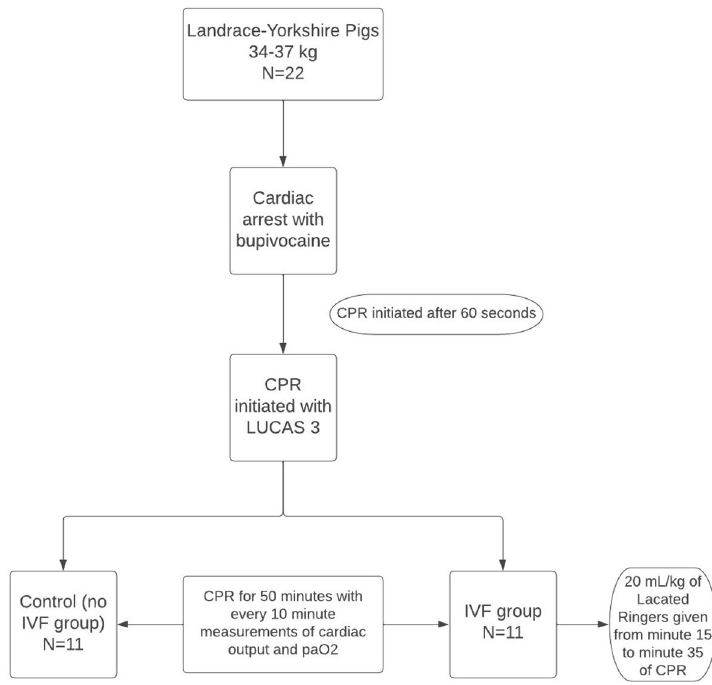
Fig. 1 Flow diagram demonstrating summary of the experimental